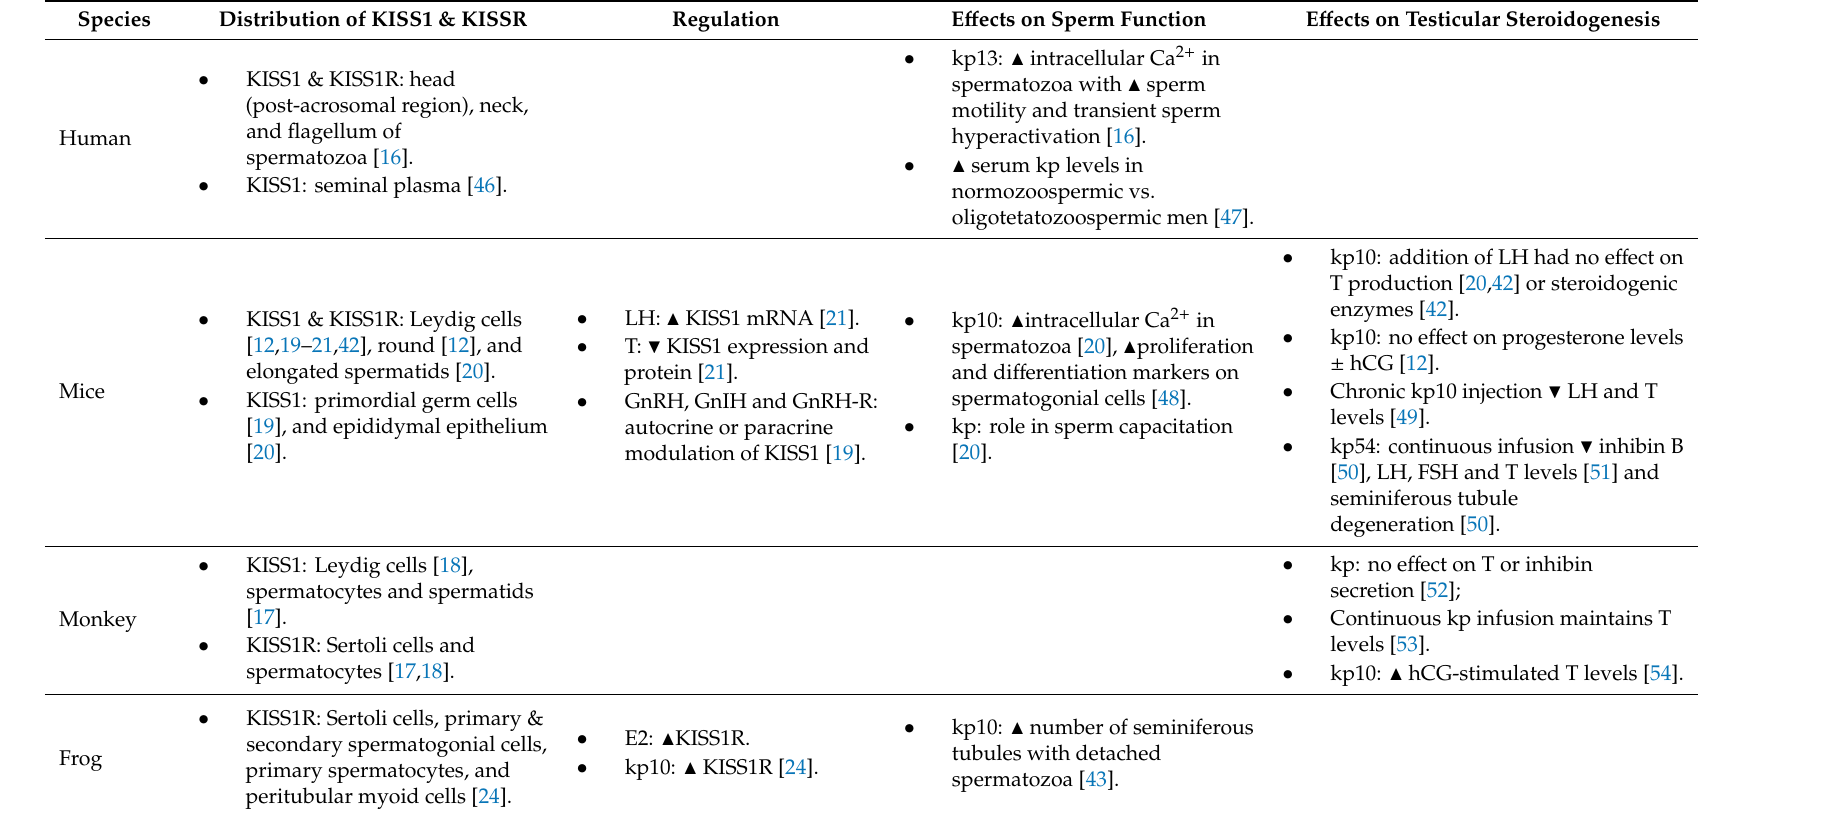
Table 1. Distribution, Regulation and E ff ects of KISS1 / KISS1R on Testicular Function in Various